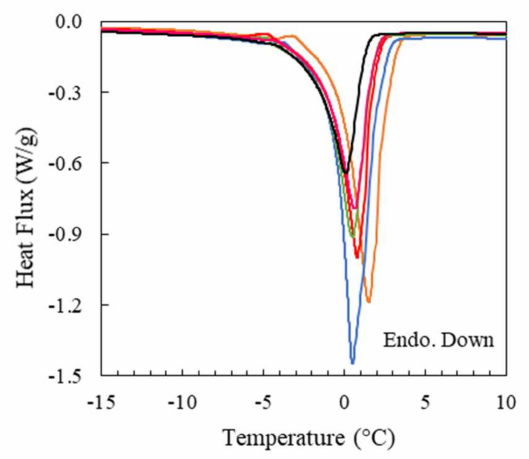
Figure 13. Heating thermograms of GE and Ionogels at 1 ◦ C/min: ( — ) GE, ( — ) GE/1IL, ( — ) GE/5IL, ( — ) GE/10IL, ( — ) GE/15IL and ( — ) GE/25IL.